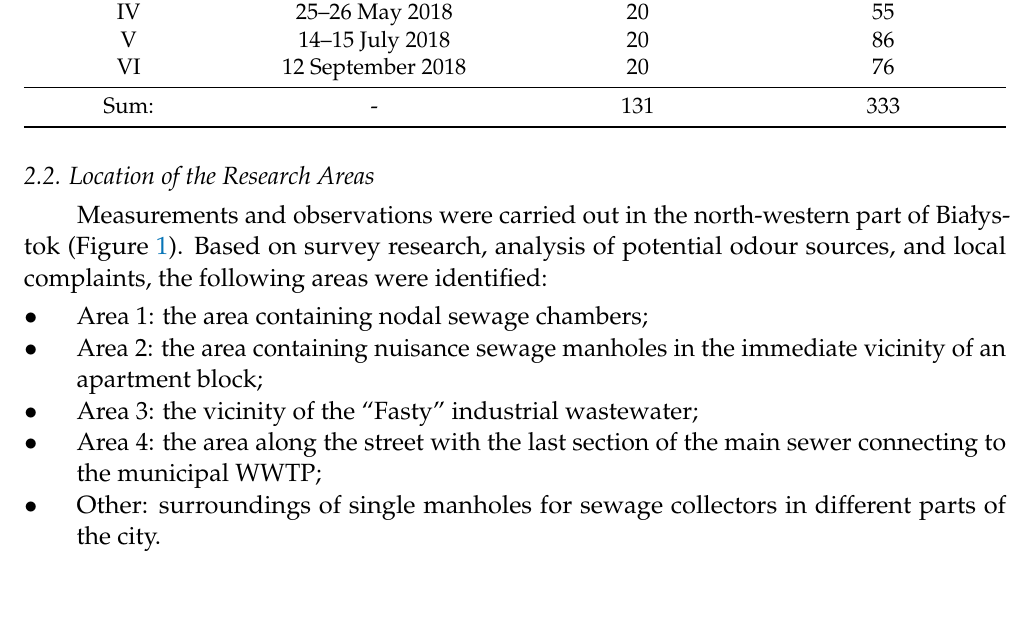
Series No. Research Date